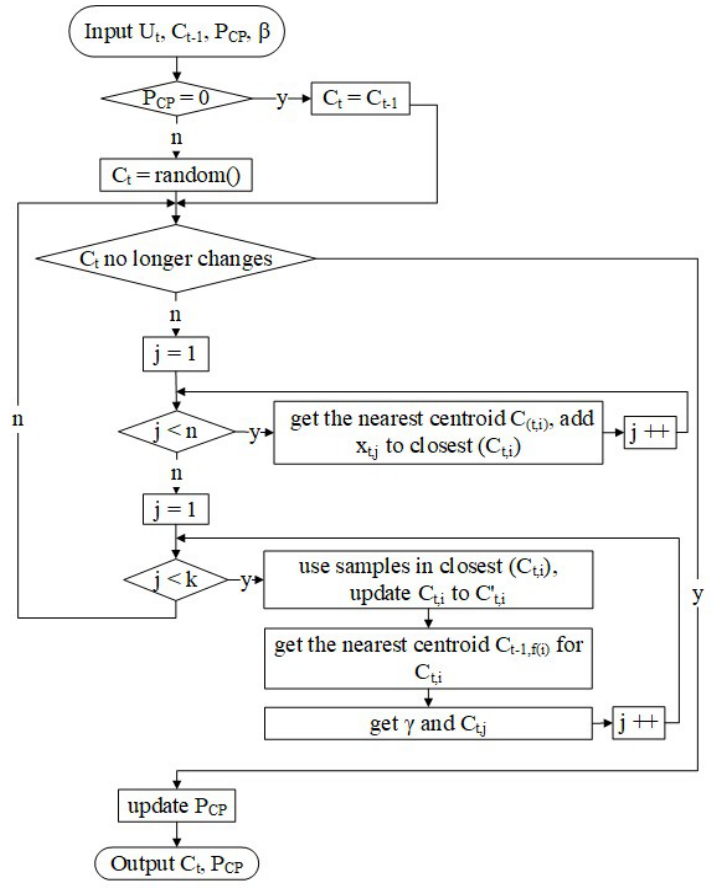
Figure 4. Flow diagram of optimized evolutionary clustering.